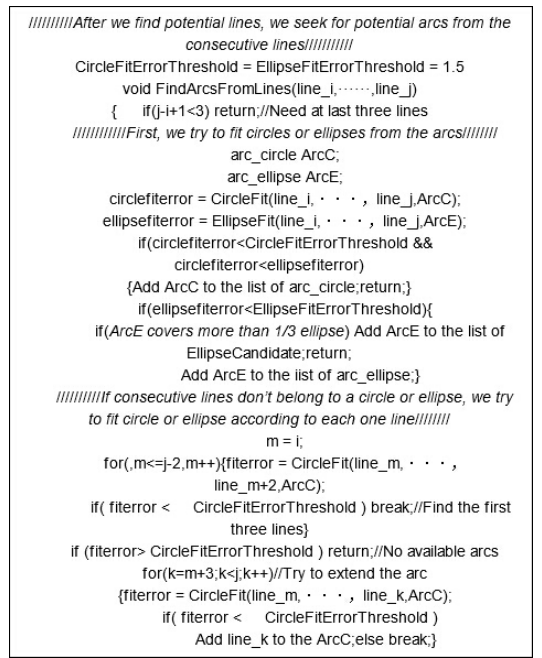
Figure 9: Algorithm to fit circles from every circle cluster